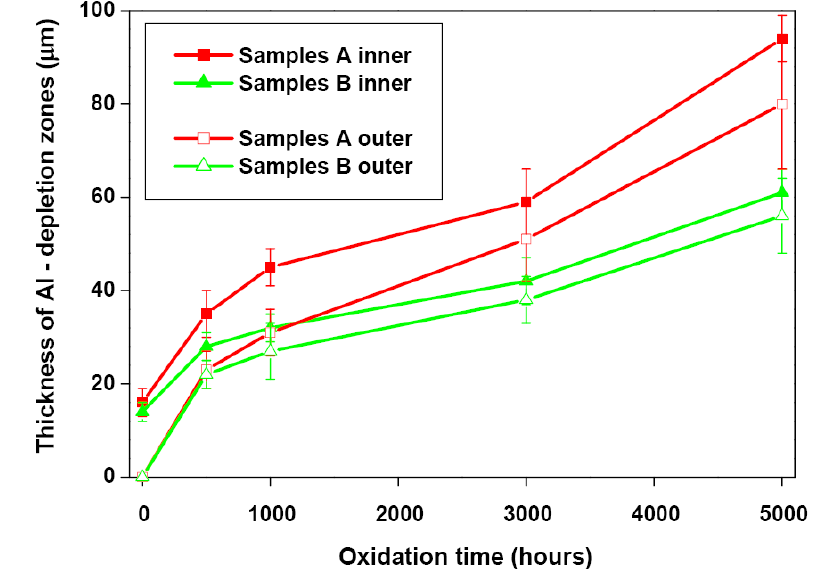
Figure 5. Thickness of the inner and outer aluminium depletion layers of samples A and B before and after different periods of oxidation at 1,273